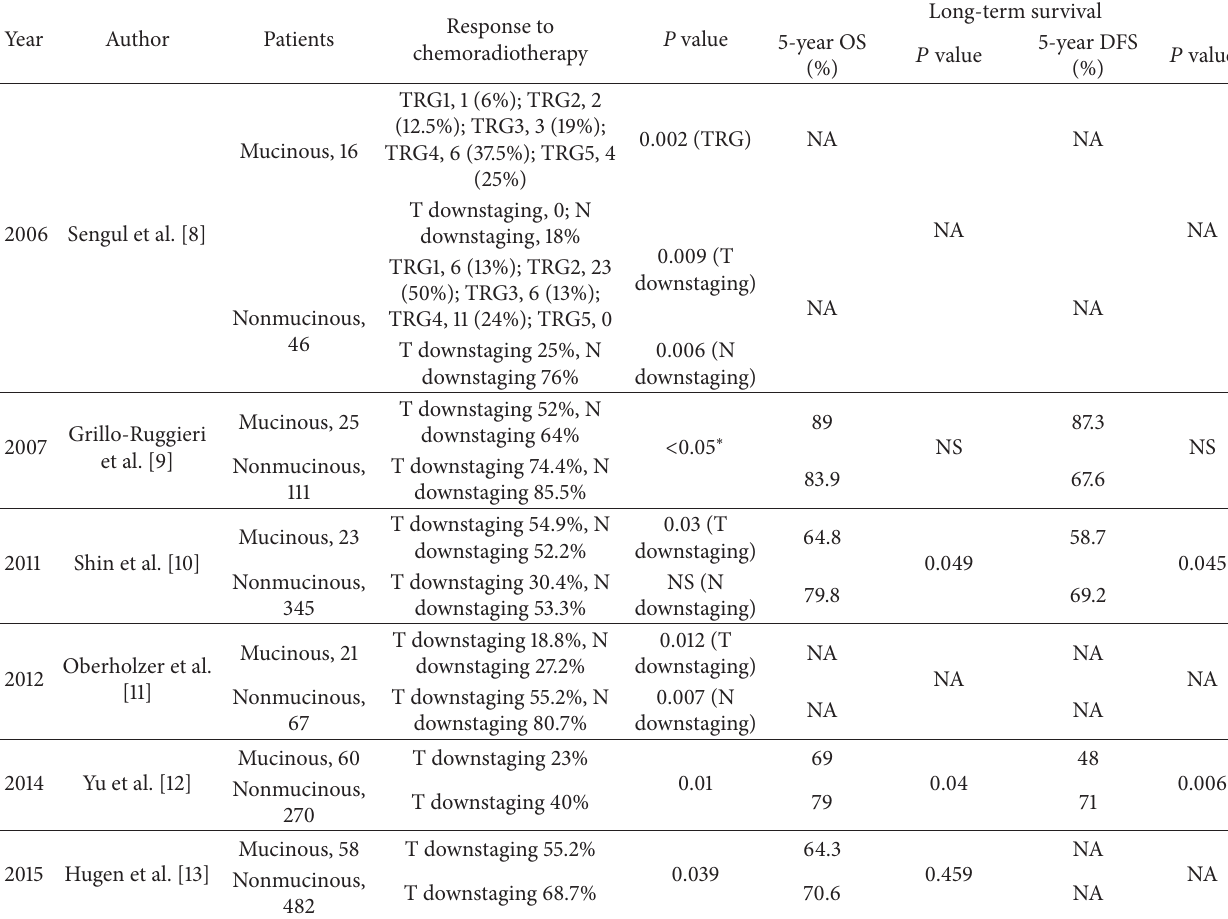
Table 5: Previously reported outcomes between mucinous and nonmucinous rectal cancer treated with neoadjuvant